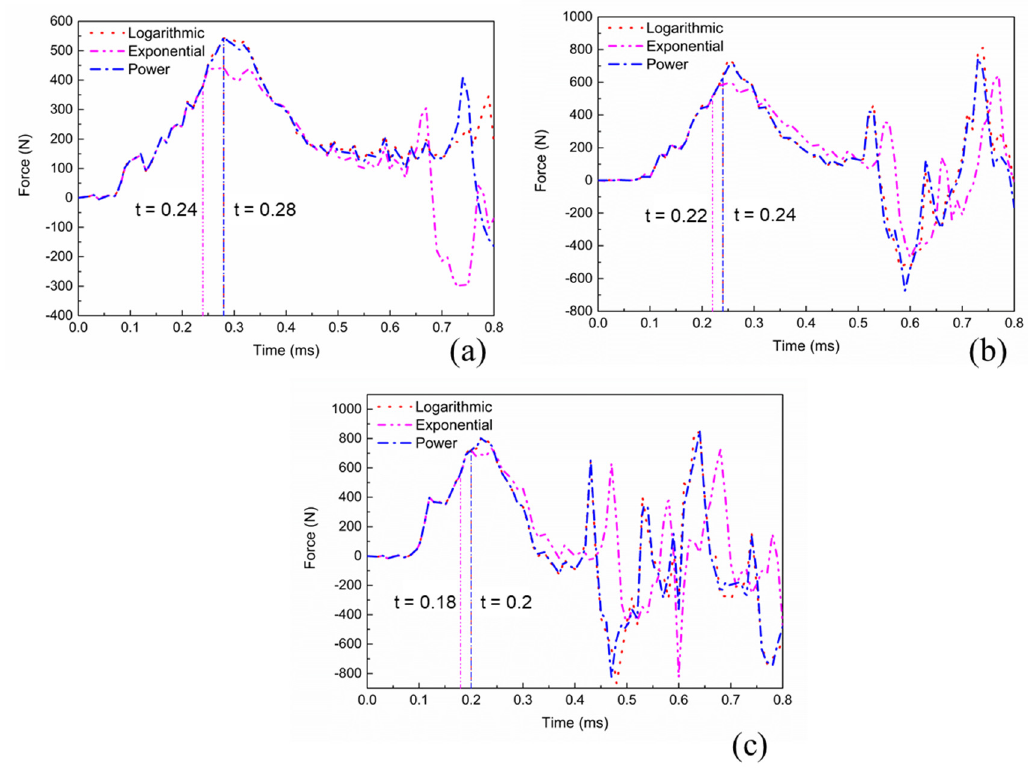
Figure 7. Force-time curves of crack tip speed of ( a ) 108, ( b ) 175, ( c ) 253 m/s.